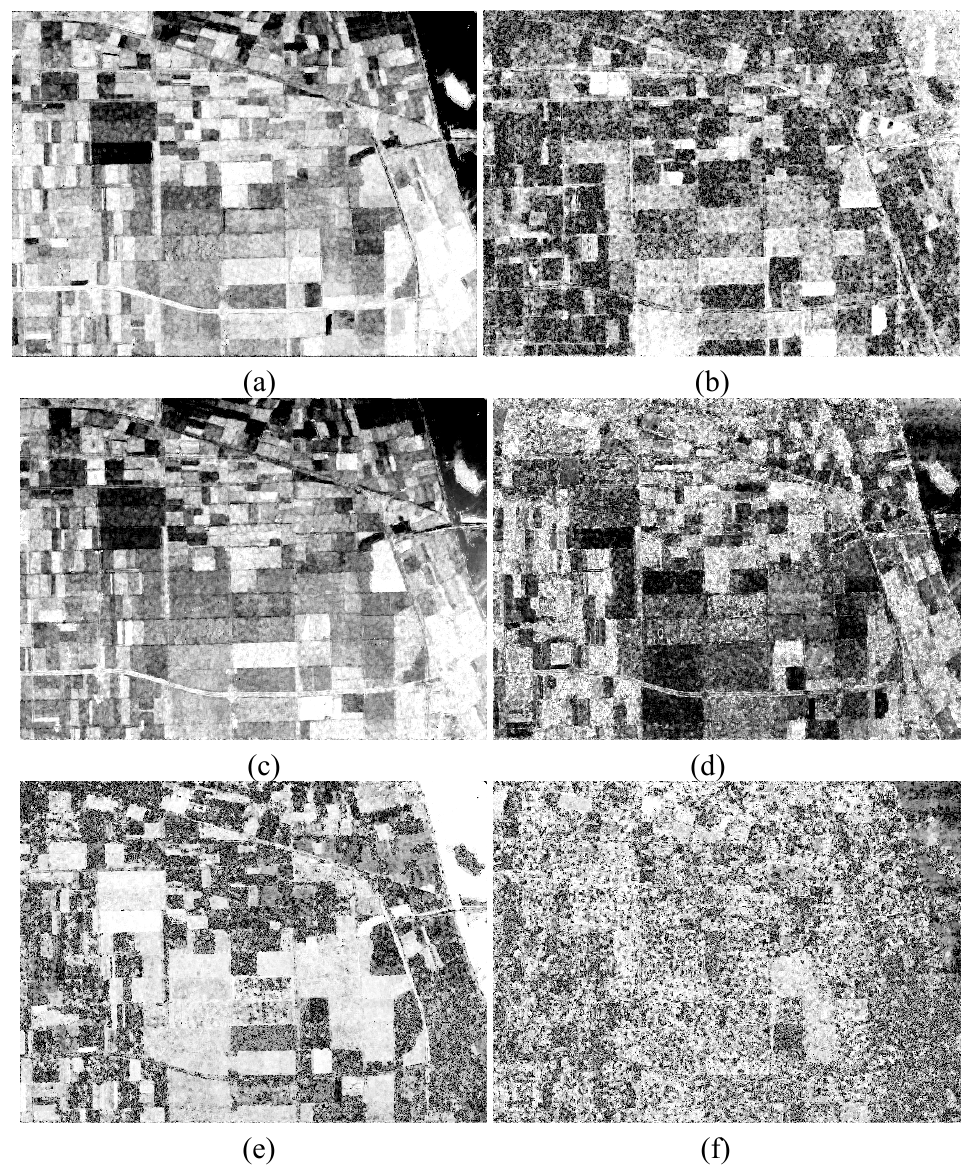
Figure 9. Parameters of H/A/ α decomposition. ( a ) H ; ( b ) A ; ( c )  ; ( d )  ; ( e )  ; ( f )  .